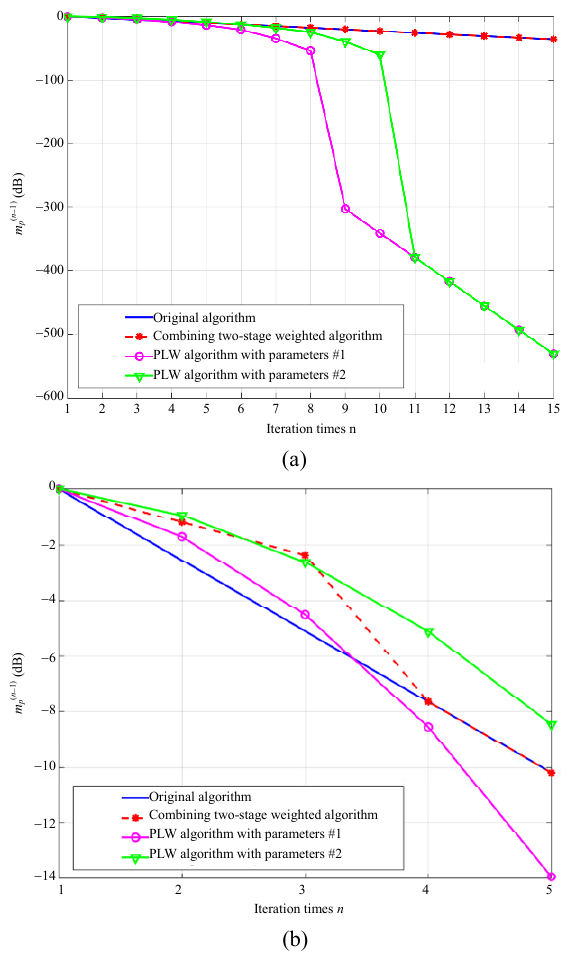
Fig. 8 Changes in m p ( n  1) with different iterative algorithms in the alignment process: (a) shows the changes in m p ( n  1) in the whole alignment process ( n ≤ 15) and (b) shows the changes in m p ( n  1) at the beginning of the alignment process ( n ≤